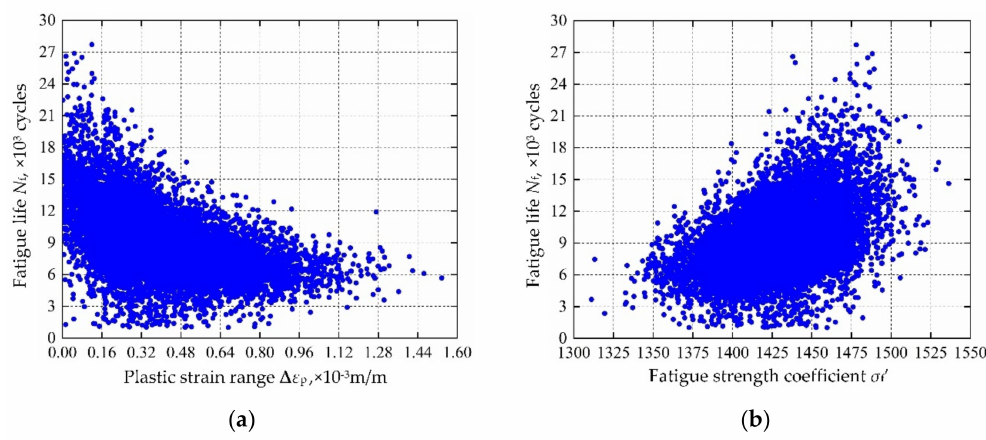
Figure 21. Scatter sketches of fatigue life: ( a ) plastic strain range, ( b ) fatigue strength coe ffi